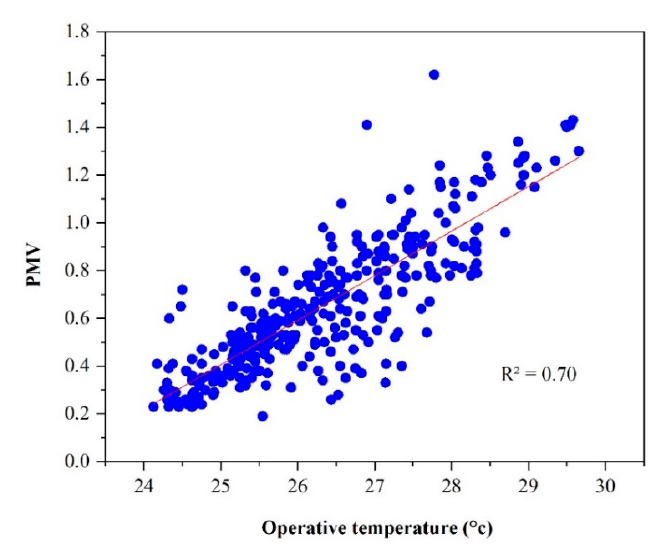
Figure 10. Relationship between PMV and operative temperature.